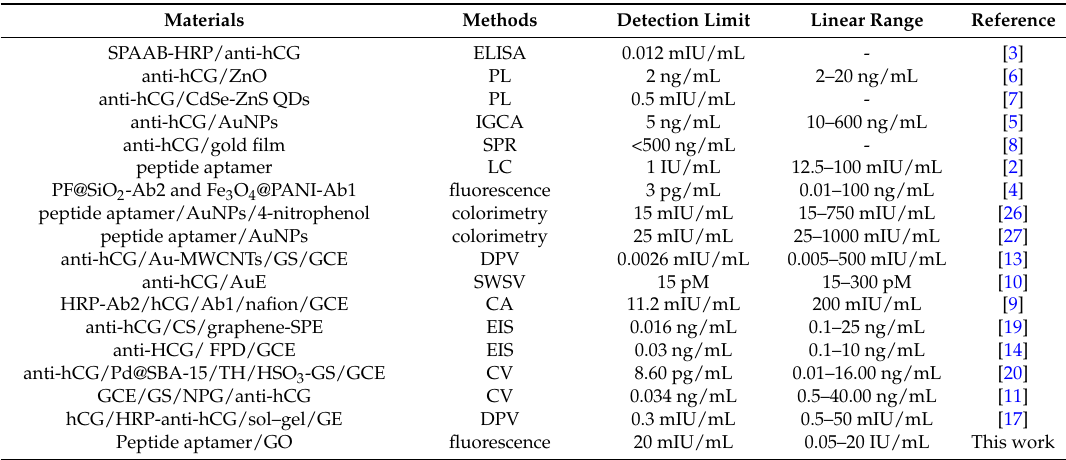
Figure 4. ( A ) Fluorescence spectra of FITC-PPLRINRHILTR/GO in the presence of different concentrations of hCG; ( B ) Dependence of fluorescence intensity on hCG concentration. The inset shows the linear segment in the range of 0.05 to 20 IU/mL. Table 1. Analytical performances of various methods for hCG detection.